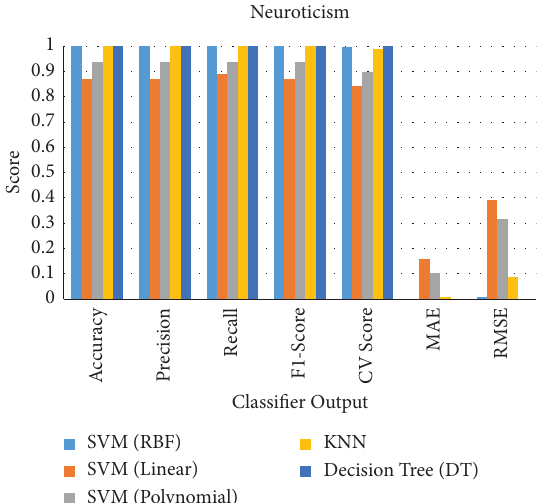
Figure 7: Overall score of the classifcation report, k -fold CV ( k � 10), MAE, and RMSE for the extroversion model.